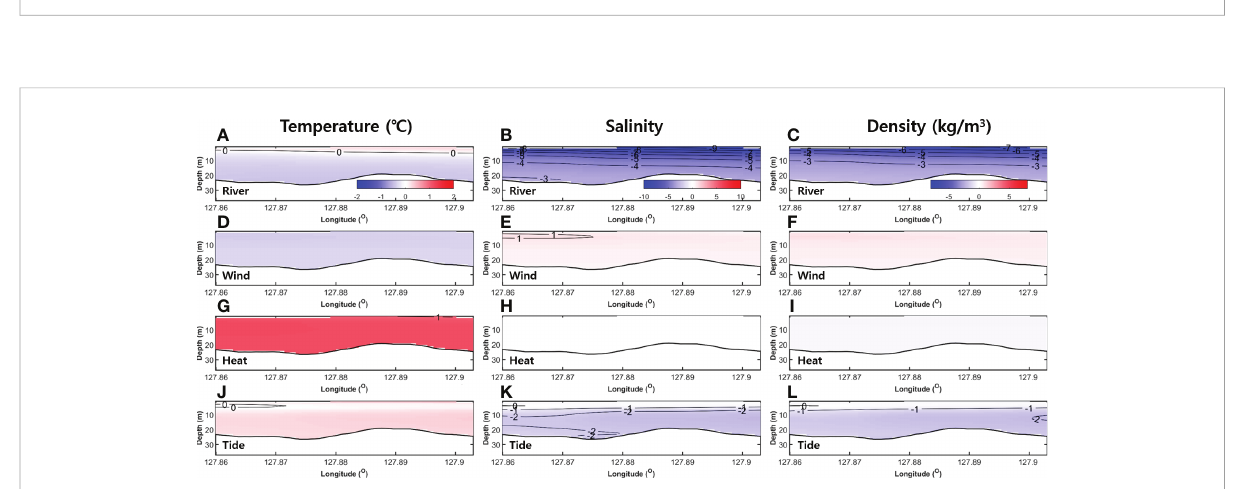
FIGURE 9 Differences in the [ (A) , (D) , (G) , (J) ] temperature, [ (B) , (E) , (H) , (K) ] salinity, and [ (C) , (F) , (I) , (L) ] density of the control experiment and the [ (A) , (B) , (C) ] river, [ (D) , (E) , (F) ] wind, [ (G) , (H) , (I) ] heat, and [ (J) , (K) , (L) ] tide experiments along Noryang Channel averaged from 26 June to 24